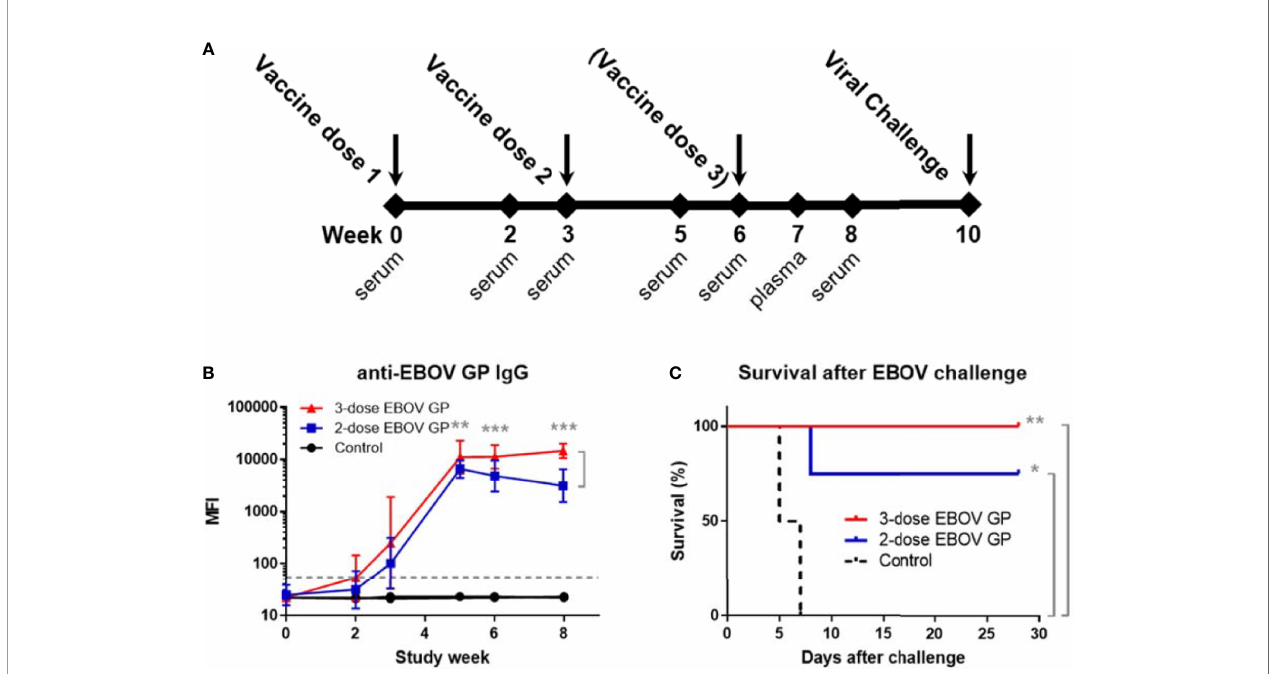
FIGURE 1 | Standard study schedule, immune response to EBOV GP, and survival after EBOV challenge. (A) Each study described followed a standard schedule in which cynomolgus macaques were vaccinated at three-week intervals with either two or three doses of vaccine. Controls received adjuvant only. Serum or plasma samples were collected periodically. Animals were challenged with 1,000 PFU of virus at week 10 after initial vaccination. (B) Anti-EBOV GP IgG antibodies were measured by MIA at time points relative to fi rst vaccination with EBOV GP. Samples were assayed in triplicate. Each data point for vaccinated groups represents geometric mean ± 95% con fi dence interval whereas data points for controls were plotted per individual animal. The dashed grey line marks the threshold for positive detection of anti-EBOV GP IgG at 3 standard deviations (SD) above mean MFI of negative control samples. (C) Kaplan-Meier survival curves after challenge with EBOV. *p < 0.05, **p < 0.01, ***p <